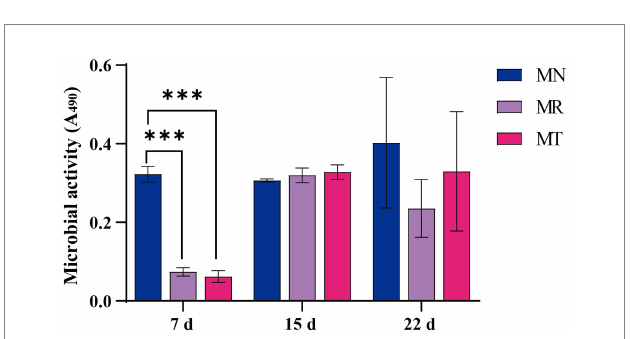
FIGURE 5 Effect of SMD on fecal microbial activity in mice with spleen deficiency